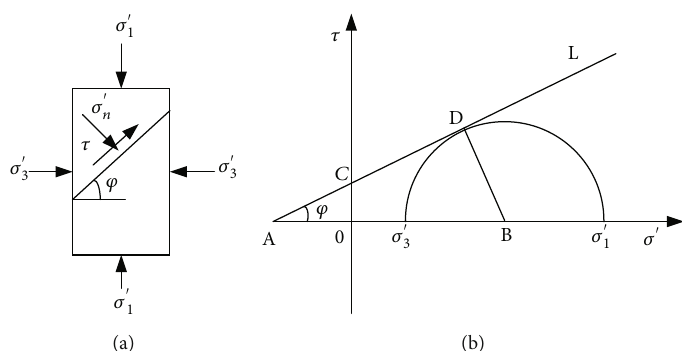
Figure 1: Coulomb criterion in σ ‐ τ coordinate. (a) The Shear failure diagram. (b) The Mohr circle of stress.